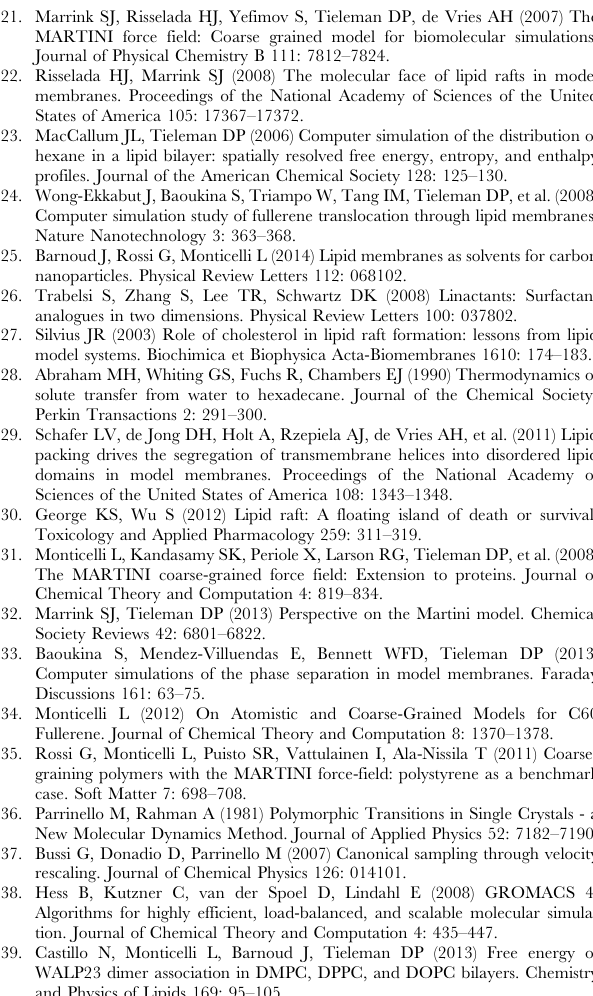
the right panels. Right panels: difference in thickness between the DLiPC-rich and the DPPC-rich phases, in the absence and in the presence of different solutes. Numbers in parentheses indicate different replicas of the simulations. (TIFF) Figure S4 Robustness of the results. Snapshots of a single leaflet from simulations of systems with high concentration of benzene at 325 K, carried out with the original MARTINI force field (left panel) and the modified force field (right panel). Colors are the same as in Fig. 1: DPPC is colored in blue and DLiPC in red.